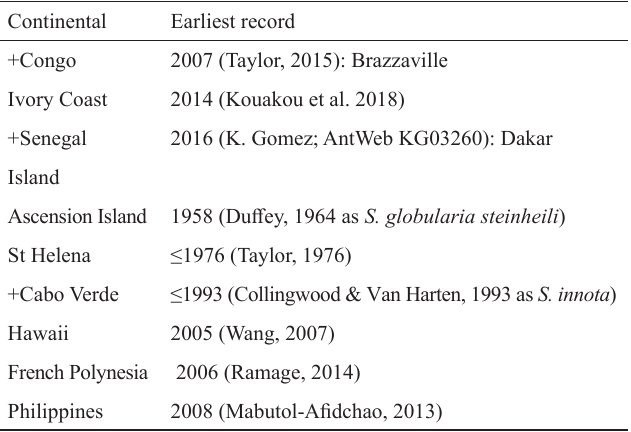
Table 3 . Earliest known records for Solenopsis globularia outside the New World. + = no previously published